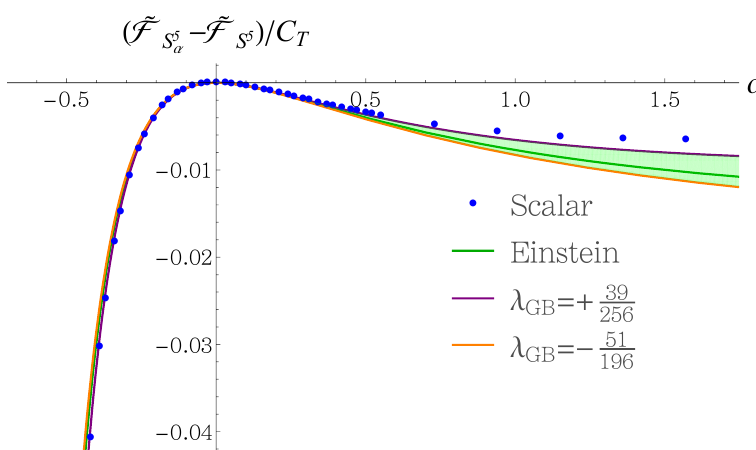
Figure 5 . A plot of ( ~ F (cid:0) ~ F ) =C as a function of (cid:11) for a free scalar (blue dots), and for S 5 (cid:11) S 5 T holographic theories dual to Gauss-Bonnet gravity (green shaded region). The holographic results include the Einstein theory (green) and the limiting cases (4.21) allowed by causality in the dual CFT (purple and